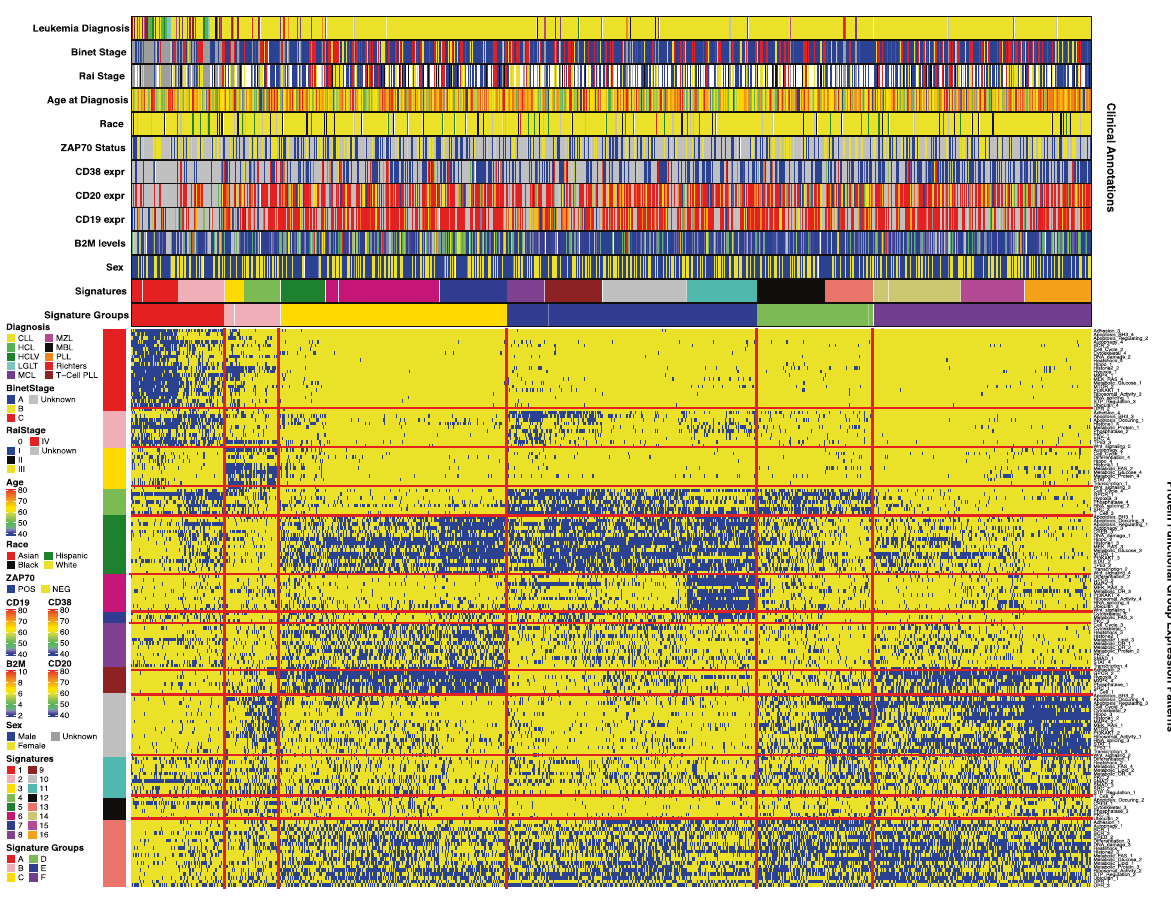
Fig. 2 Metagalaxy heatmap of signatures, constellations, and clinical annotations. The heatmap displays the presence(blue) and absence (yellow) of 152 protein functional group expression patterns in all patients (labeled on the right). Annotations above the heatmap display signatures, signature groups, B2M levels, CD19, CD20, and CD38 expression, ZAP70 Status, age at diagnosis, staging, and diagnosis. Thirty constellations are annotated on the left side of the fi